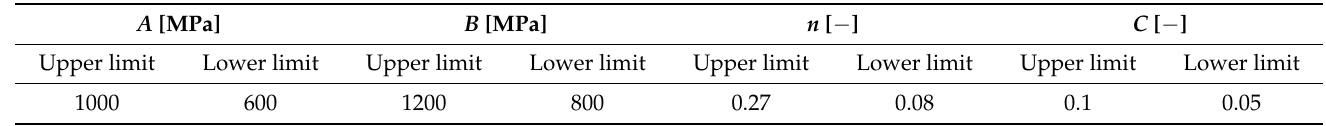
Figure 8. Changing the shear angle from separate parameters of the material model and the friction model: ( a ) initial yield stress A , ( b ) strain-hardening coefficient B , ( c ) power factor of stress hardening n , ( d ) strain rate coefficient C , ( e ) power coefficient of thermal softening m , ( f ) friction coefficient f . The specified parameter variation limits are shown in Table 3. The limits of individual parameters variation specified in Table 3 were used for the second iteration of the DOE. Table 3. Variation limits for the constitutive equation